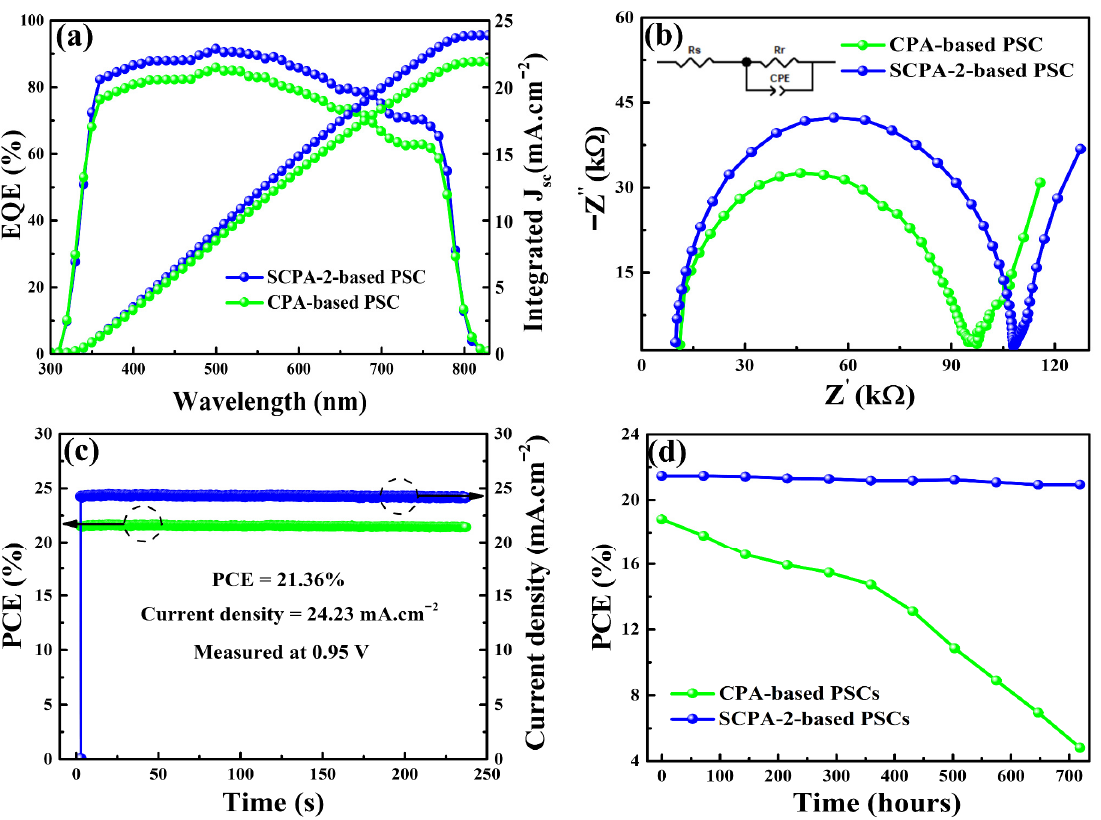
Figure 6. EQEs with integrated Jsc ( a ), EIS ( b ), and stability analyses ( c , d ) of the PSCs prepared using the CPA and SCPA-2 method. the CPA and SCPA-2